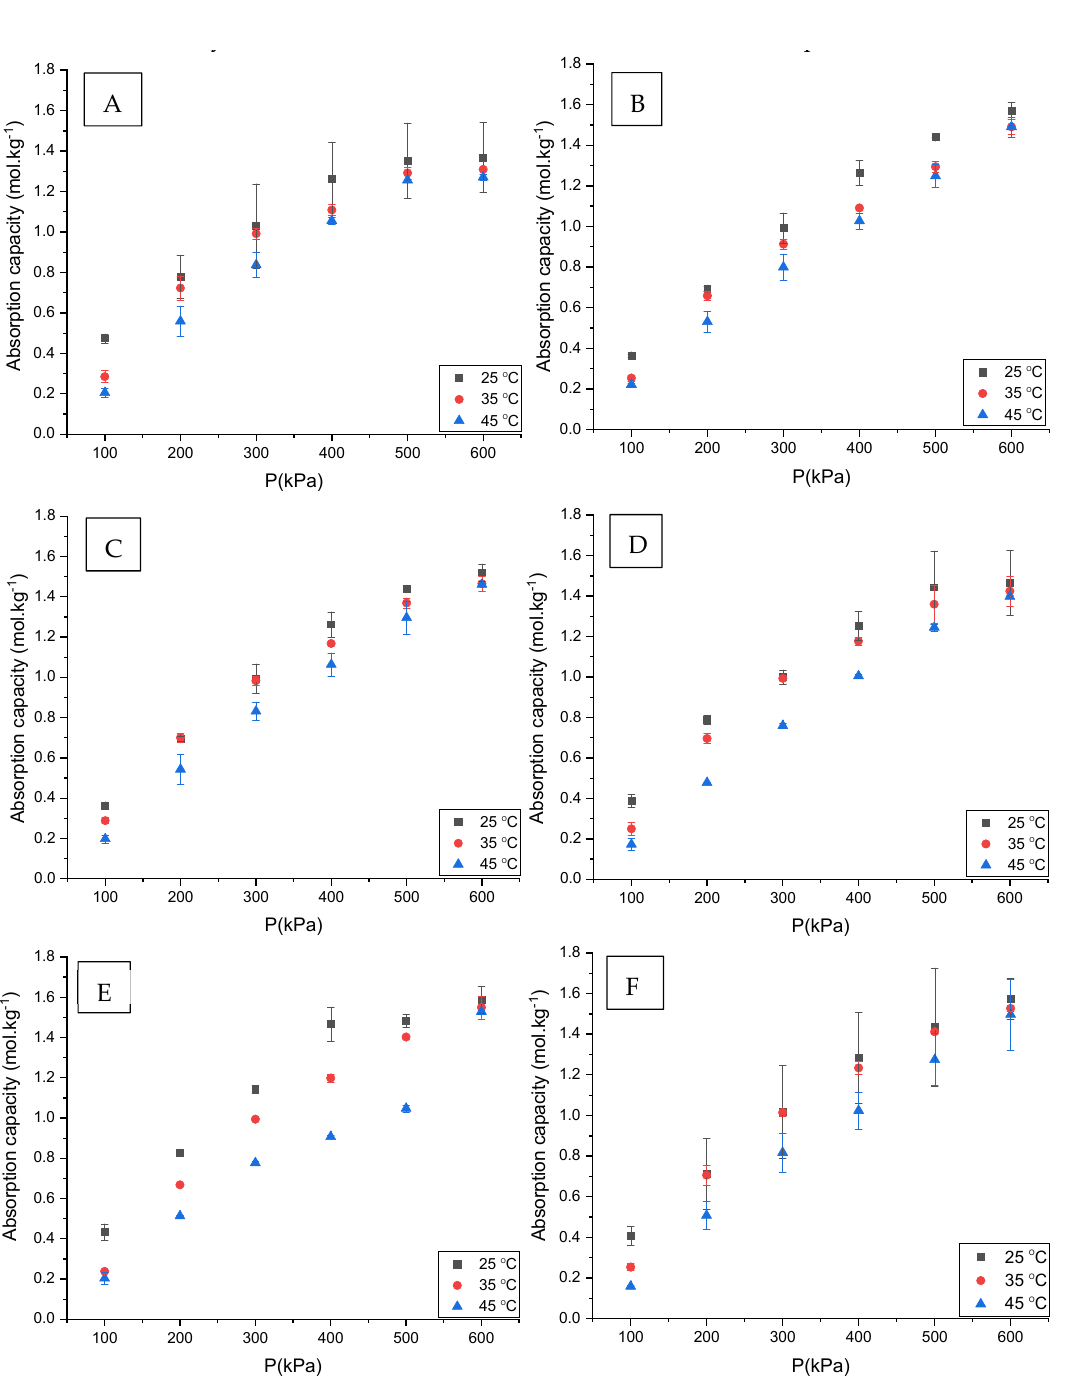
45 °C and at a constant stirring speed of 250 rpm: ( A )–1:2:0; ( B )–1:2:2.5; ( C )–1:2:5; ( D )–1:3:0; ( E )–1:3:2.5; and ( F )–1:3:5. 45 ◦ C and at a constant stirring speed of 250 rpm: ( A )—1:2:0; ( B )—1:2:2.5; ( C )—1:2:5; ( D )—1:3:0; ( E )—1:3:2.5; and ( F )—1:3:5.